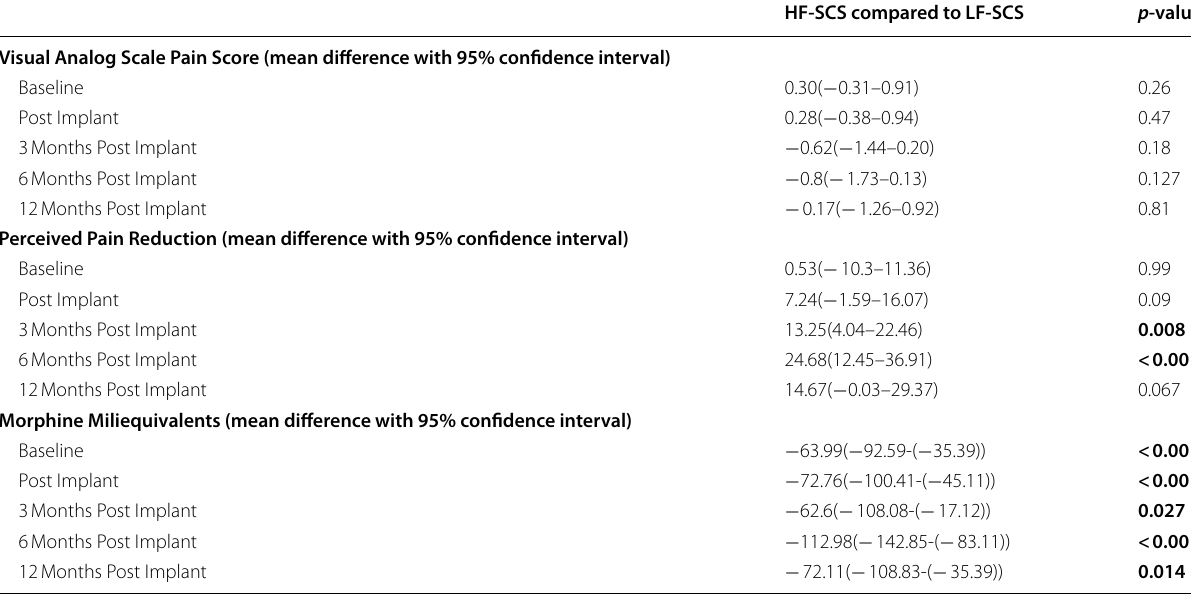
HF-SCS compared to LF-SCS p -value